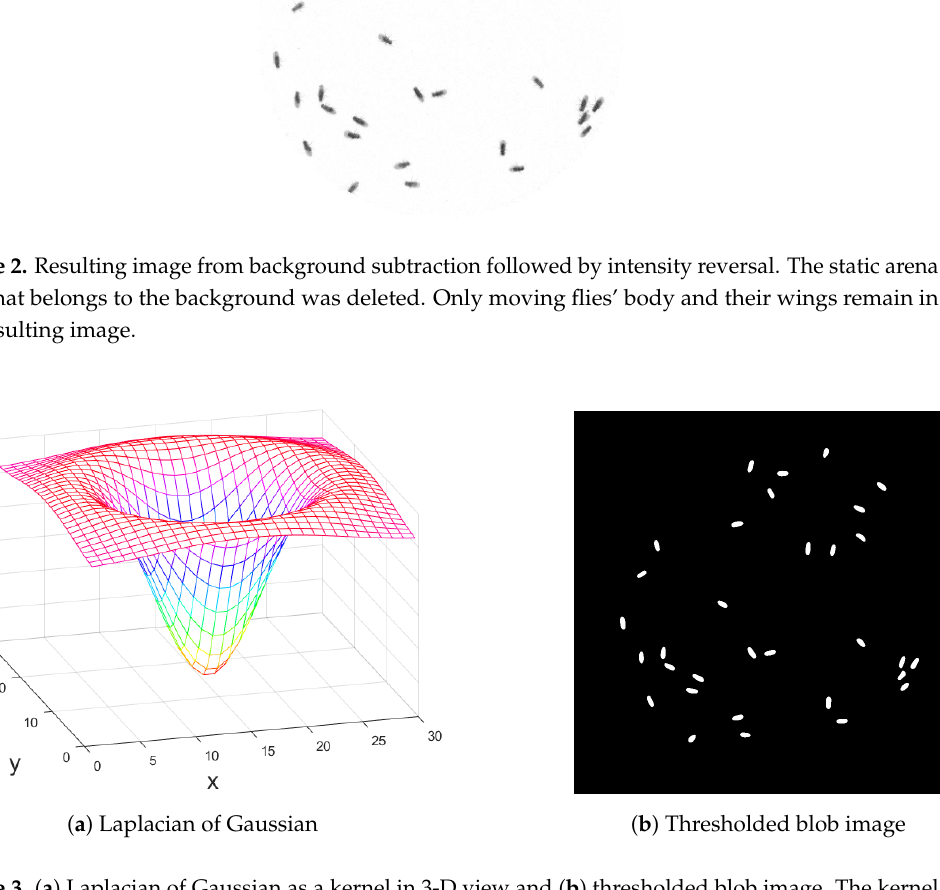
Figure 3. ( a ) Laplacian of Gaussian as a kernel in 3-D view and ( b ) thresholded blob image. The kernel is used for convolution with the resulting image from background subtraction. Thresholding is applied to the product of the convolution, resulting in the thresholded blob